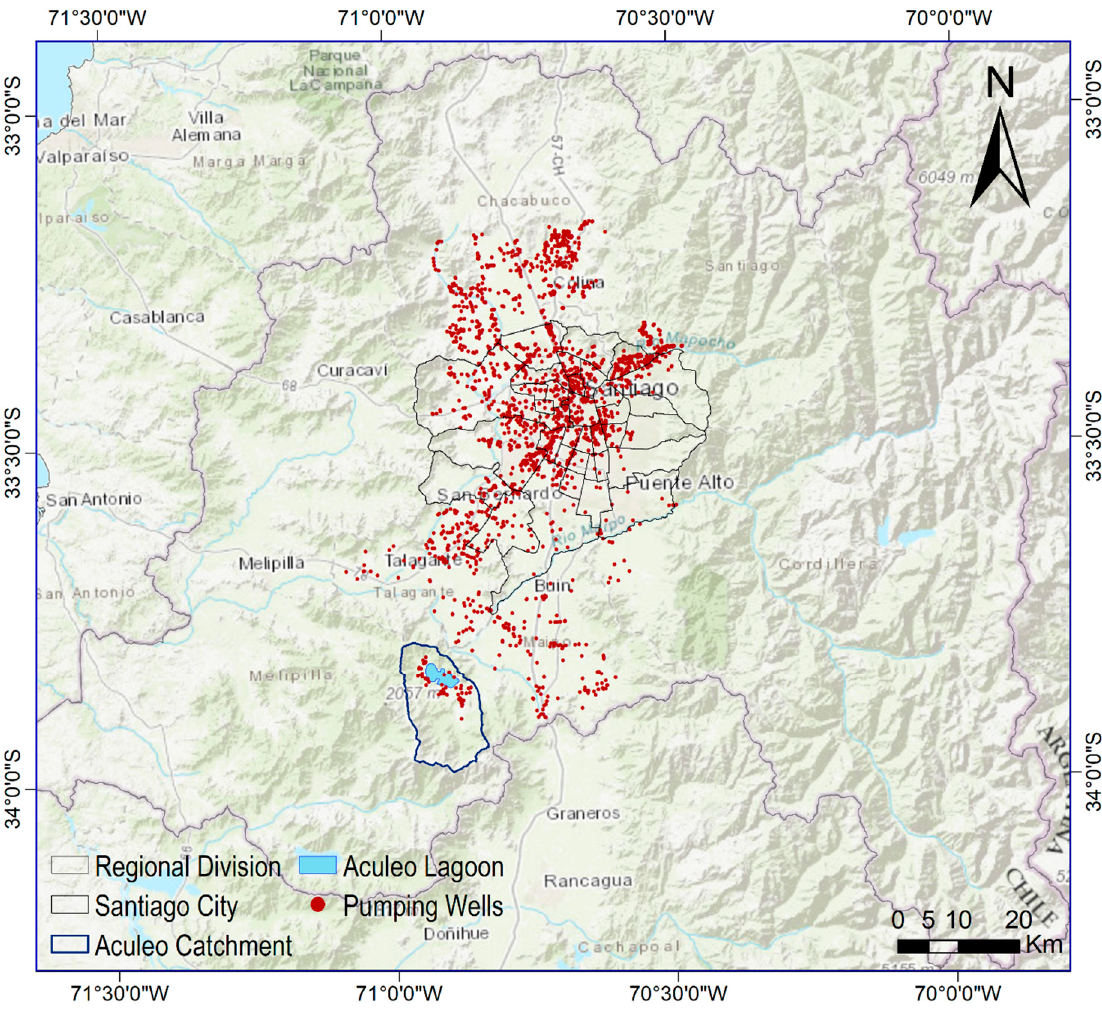
Figure 1. Location of the Aculeo Lagoon within the Metropolitan Region (Santiago), Chile. Approximately 2150 legally registered pumping wells are displayed in the map.